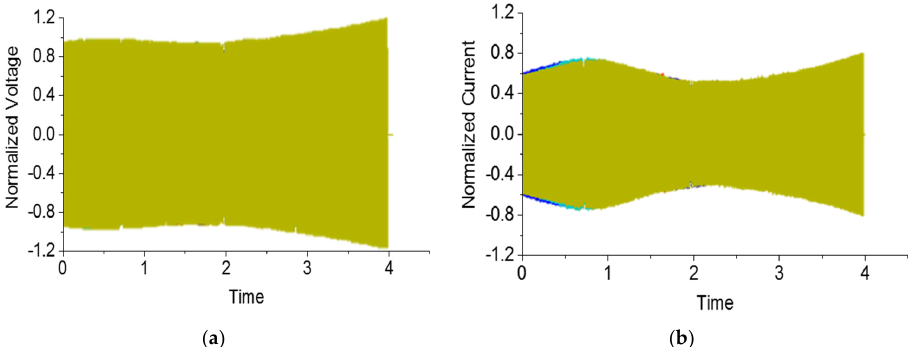
Figure 11. The output voltage and current without the control in the MCAT load: ( a ) the normalized output voltage; ( b ) the normalized output current.